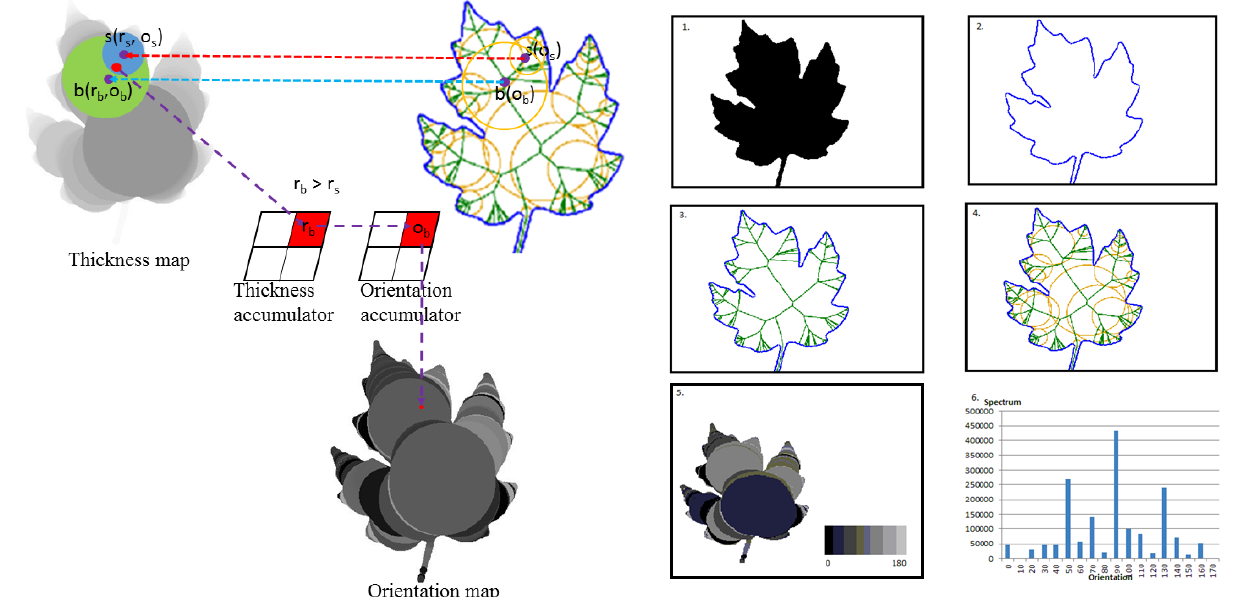
Figure 8: Creation of orientation pattern spectrum for disc SE. Steps from 1 to 6 shown. 1. 2D Shape; 2. Polygon; 3. Continuous skeleton; 4. Continuous skeleton and skeleton radial function; 5. Orientation map (orientation coded in color). 6. Orientation Spectrum as 1D